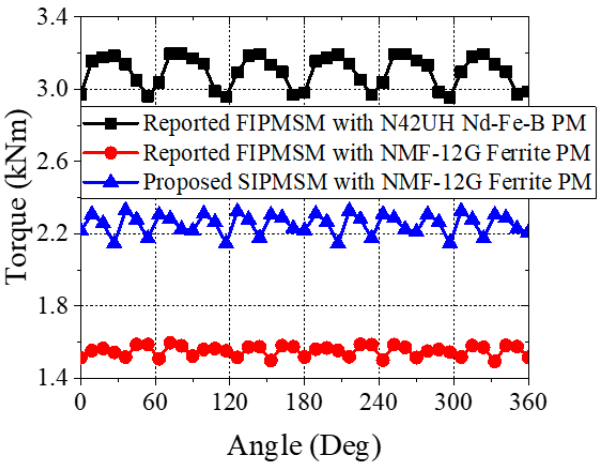
Figure 1. Schematic of 6-phase 12-slot/10-pole ( a ) reported flat-type IPMSM and ( b ) proposed spoke- type IPMSM.